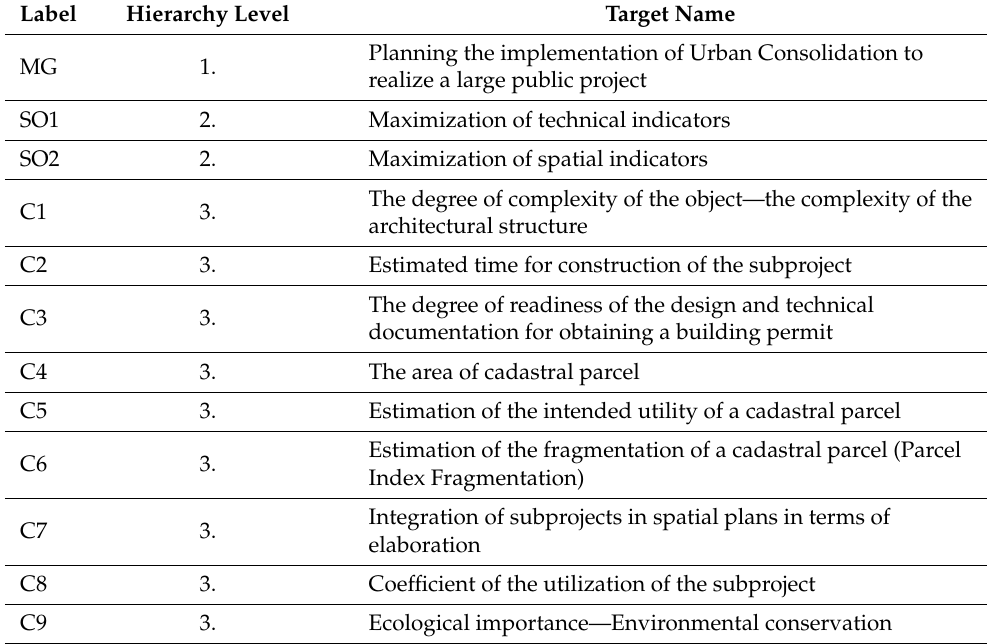
Table 1. Label, hierarchy level and target